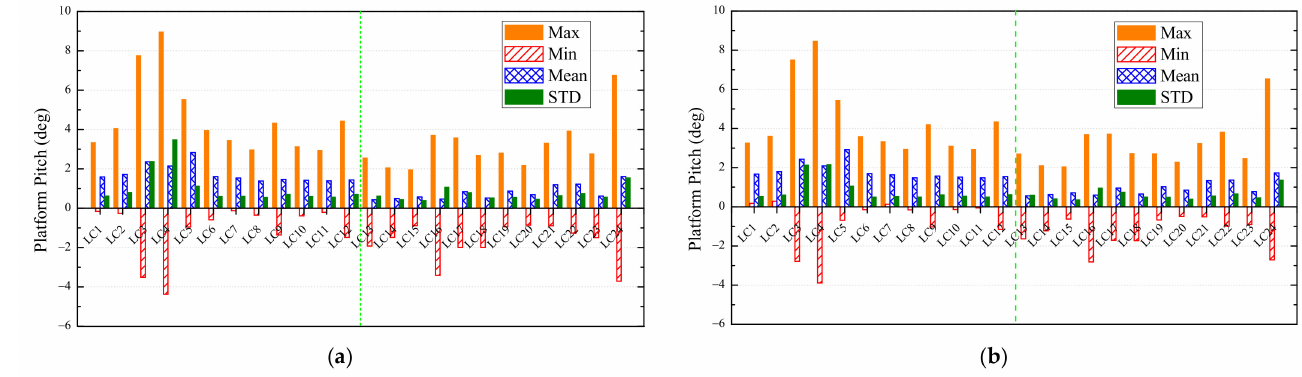
Figure 15. Statistics of platform pitch motion response for ( a ) without current; ( b ) with current.